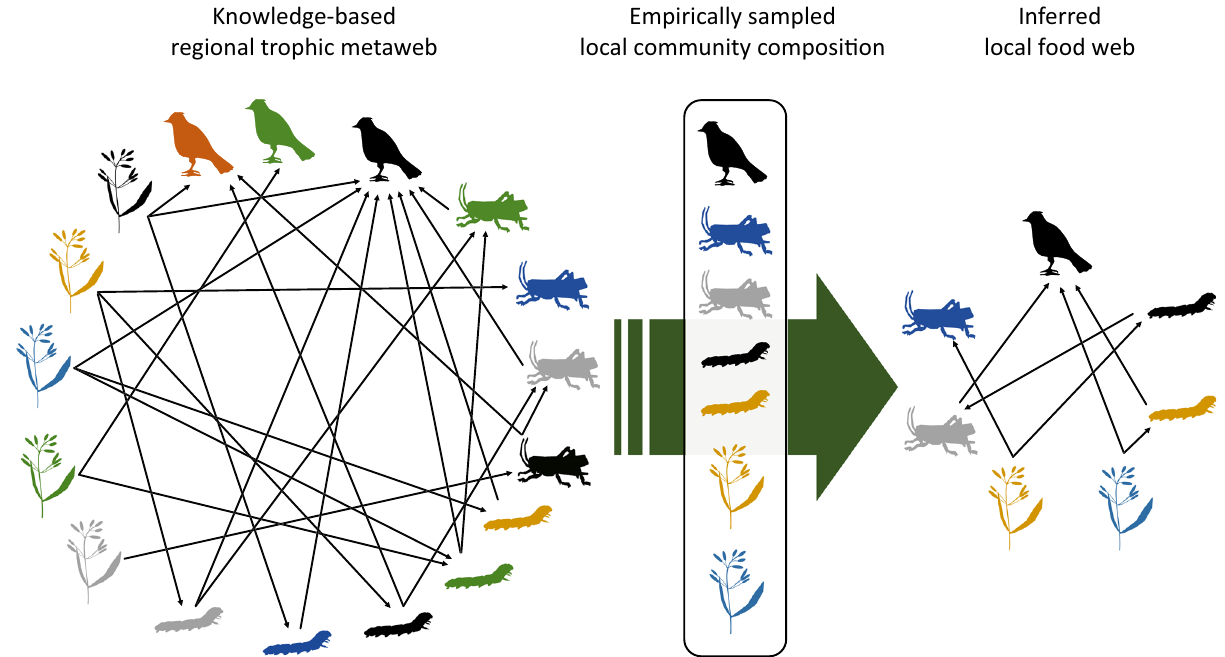
Fig. 1 | An illustration of the metaweb approach using dummy terrestrial spe- cies. Differentsilhouetteshapesandcoloursrepresentdifferentorganismalgroups and species, respectively, and black arrows indicate trophic relationships pointing from the resource to the consumer. Trophic relationships established in the